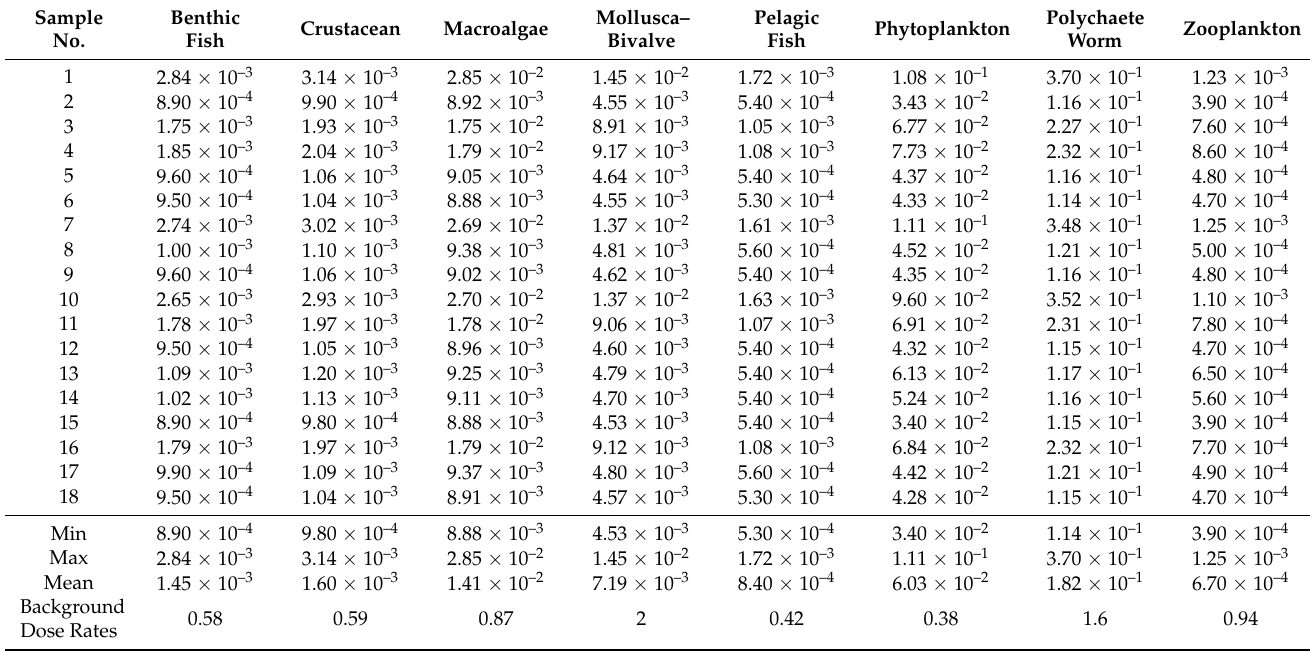
Table 5. Estimated TD for marine organism in Jeddah Coastline marine